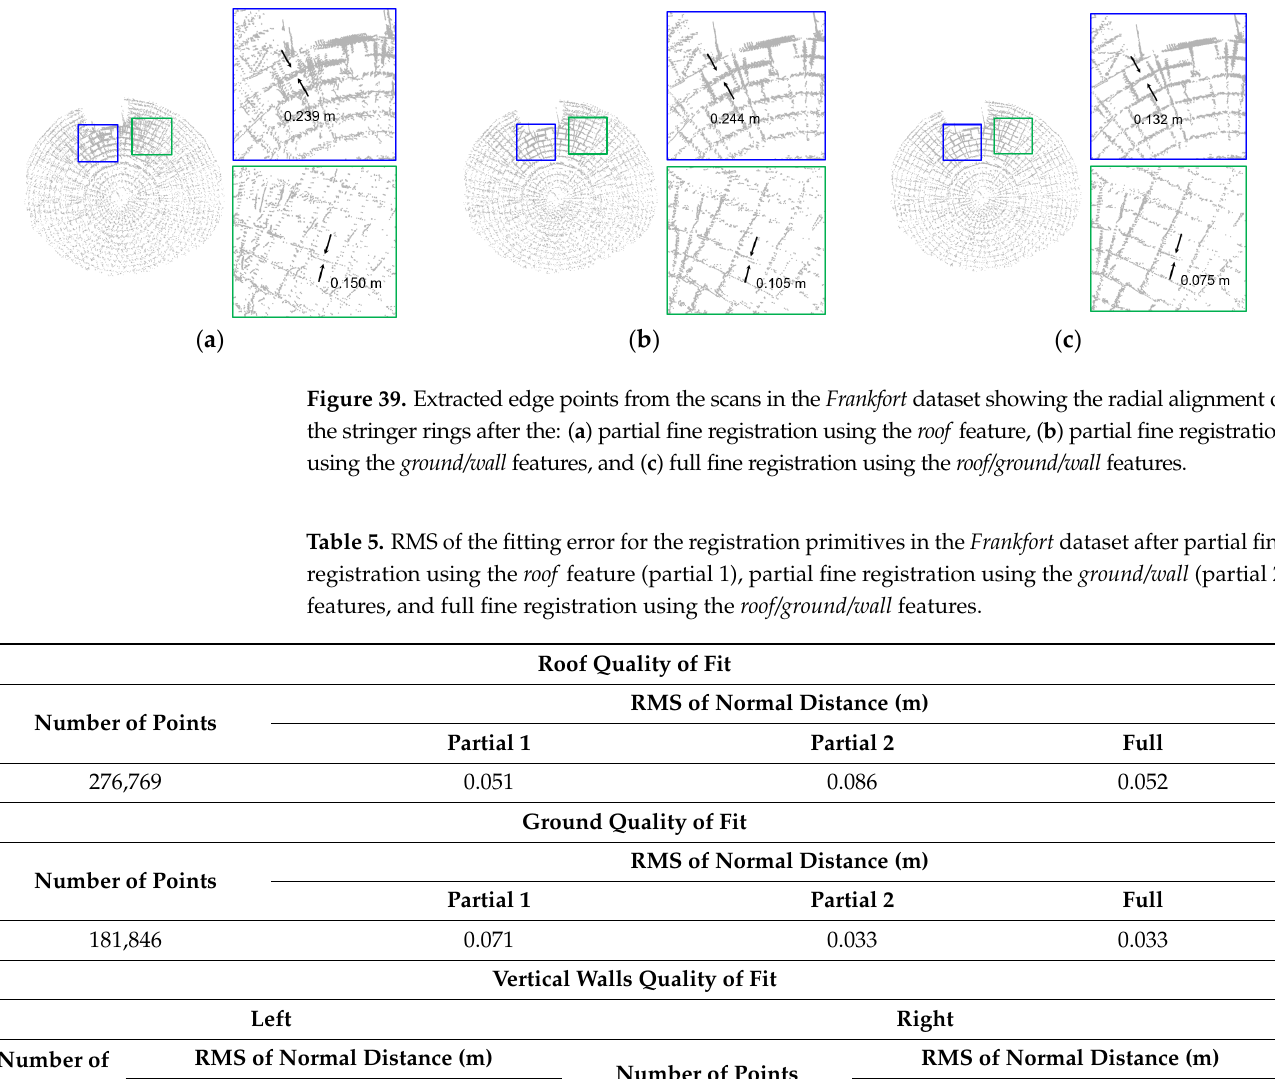
Figure 38. Extracted edge points from the scans in the Frankfort dataset showing the tangential align- ment of the radial stringers after the: ( a ) partial fine registration using the roof feature, ( b ) partial fine registration using the ground/wall features, and ( c ) full fine registration using the roof/ground/wall features.